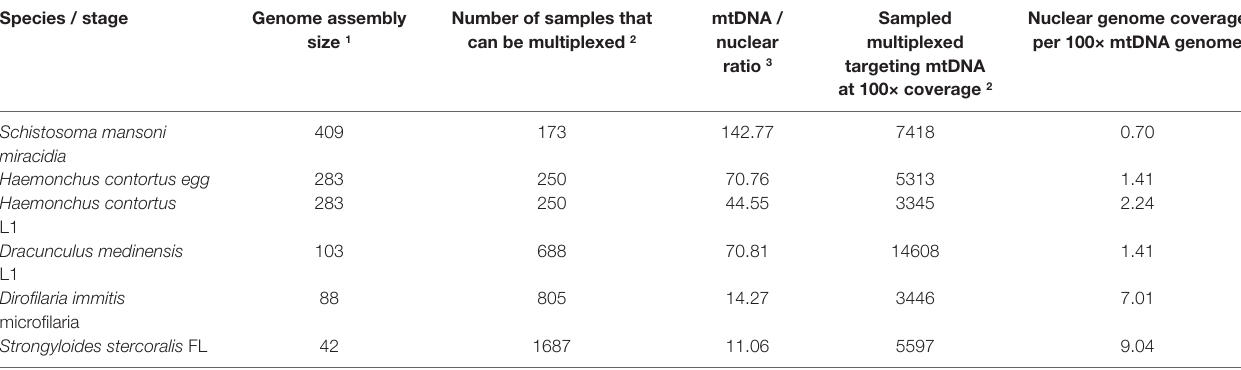
TABLE 2 | Breakdown of sequencing strategies per species based on whole-genome sequencing at 30× coverage and whole-genome sequencing to achieve 100× whole mitochondrial genome coverage. Species /